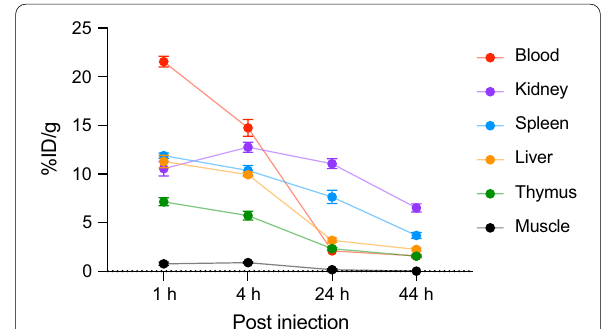
Fig. 3 In vivo biodistribution of [ 64 Cu]Cu-NOTA-CD4. [ 64 Cu] Cu-NOTA-CD4 accumulation in selected organs: blood, kidney, spleen, liver, thymus and muscle of collagen-induced arthritis mice expressed as %ID/g. Images were acquired 1, 4, 24 and 44 h p.i. ( n 6). All data are presented as mean SEM = ±